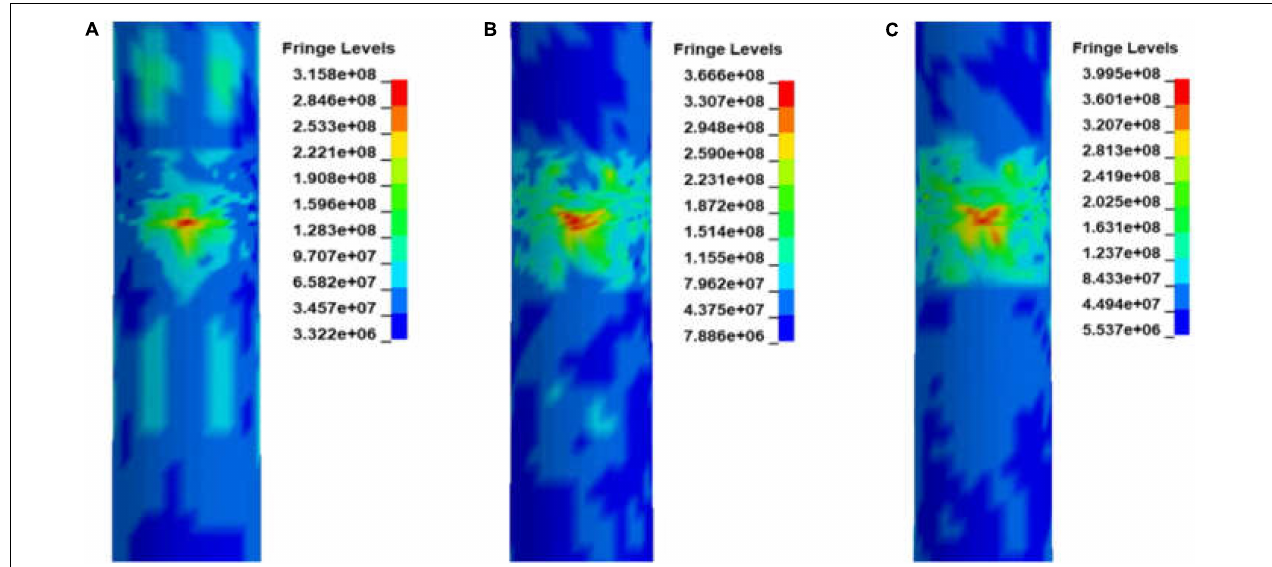
FIGURE 9 | Effective stress damage distribution diagrams at three moments. (A) Structural effective stress distribution at 1.5 s; (B) Structural effective stress distribution at 10.2 s, and (C) Structural effective stress distribution at 19.8 s.